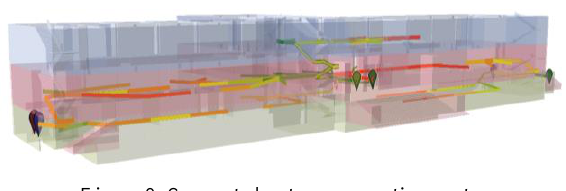
Figure 9. Generated patron evacuation